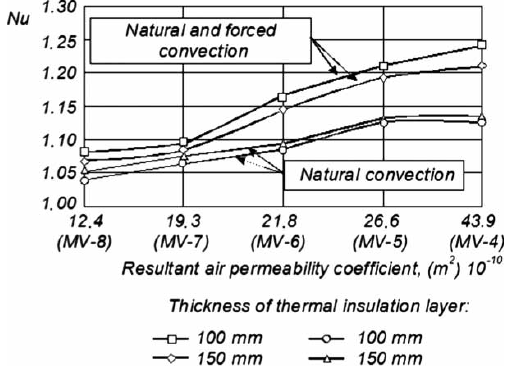
Fig. 10. The dependence of the Nusselt criterion on the resultant air permeability coefficient of mineral wool and the thickness of the layer when the external layer is non-wind- protected. The measurement carried out under environmen-